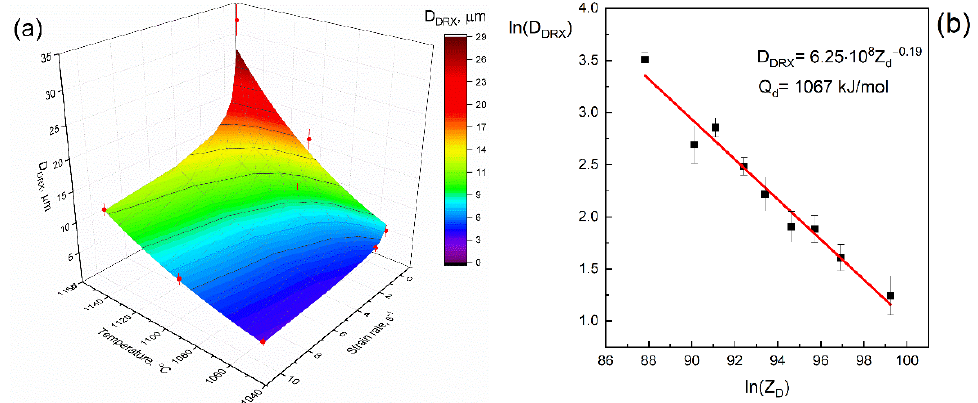
Figure 10. The dependence of dynamically recrystallized grain size on the deformation temperature and strain rate ( a ). The ln(D DRX ) vs. Z D plot ( b ).